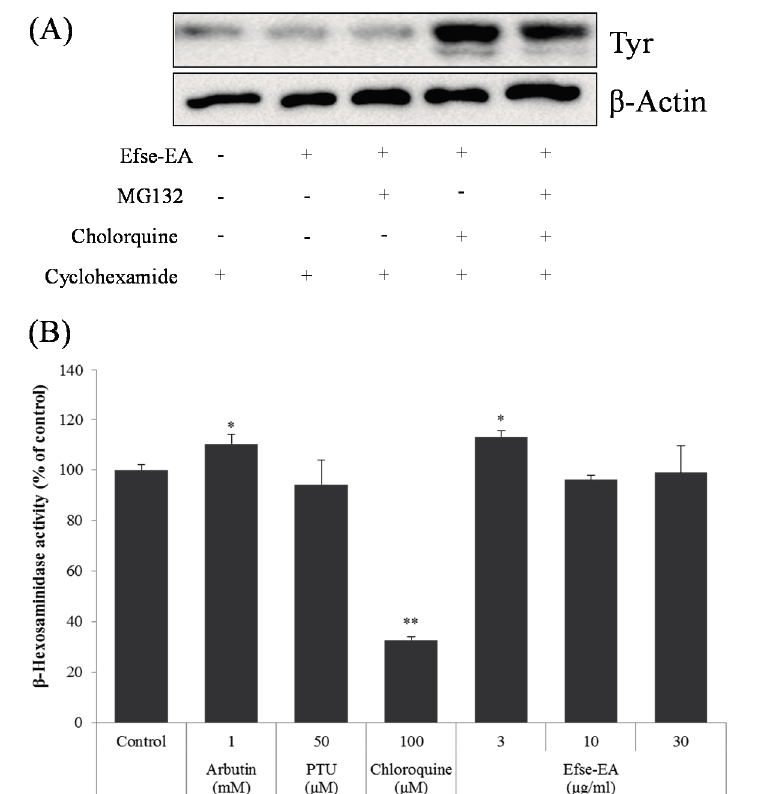
Figure 6. Effect of Efse-EA on lysosomal tyrosinase degradation in melan-a